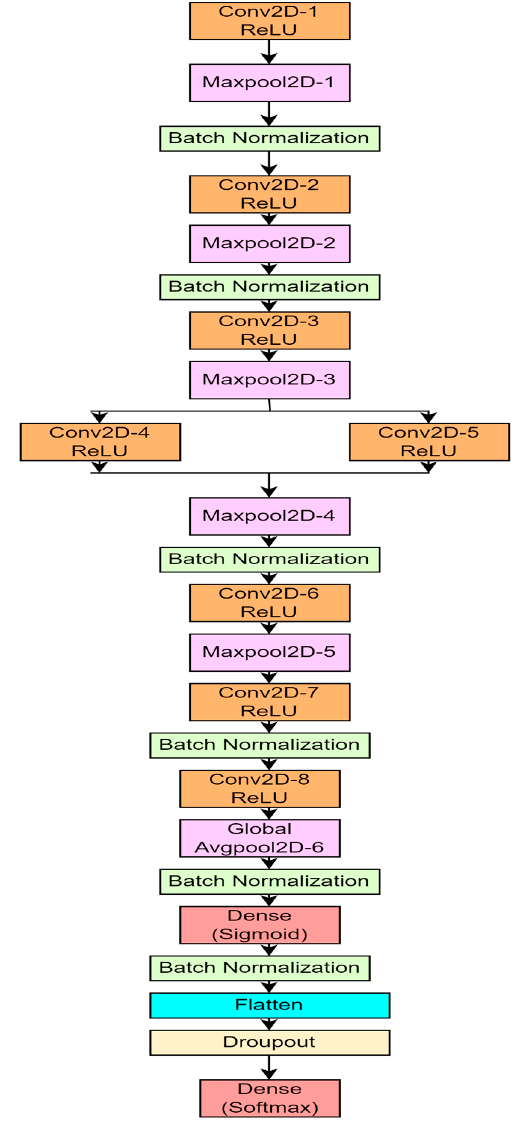
Figure 4. Architecture of proposed 10-layer CNN.